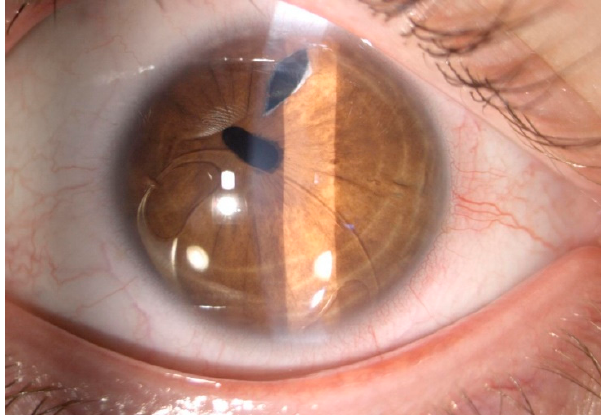
Figure 6. Slit-lamp photograph of a subluxated anterior chamber iris-claw (Artisan) IOL.